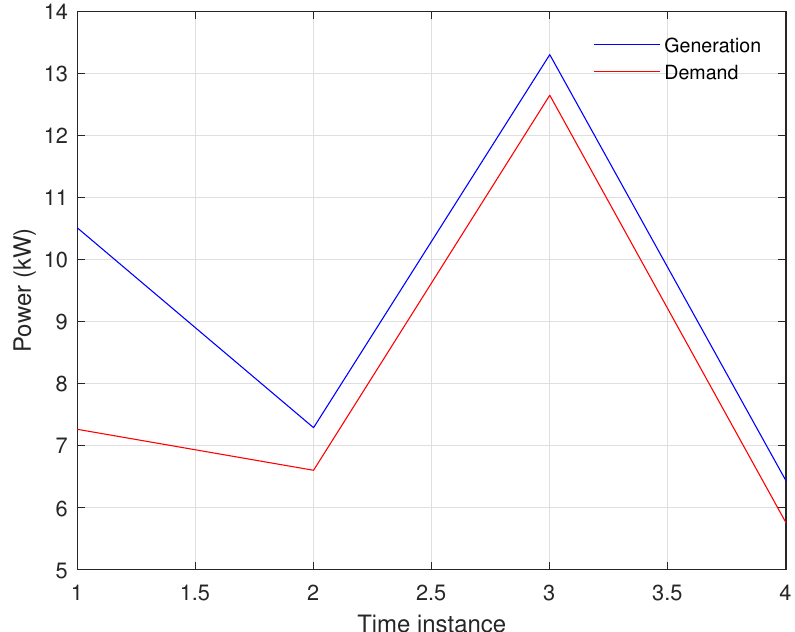
Figure 7. Demand and supply profile during shortfall after SLS for data set-2.